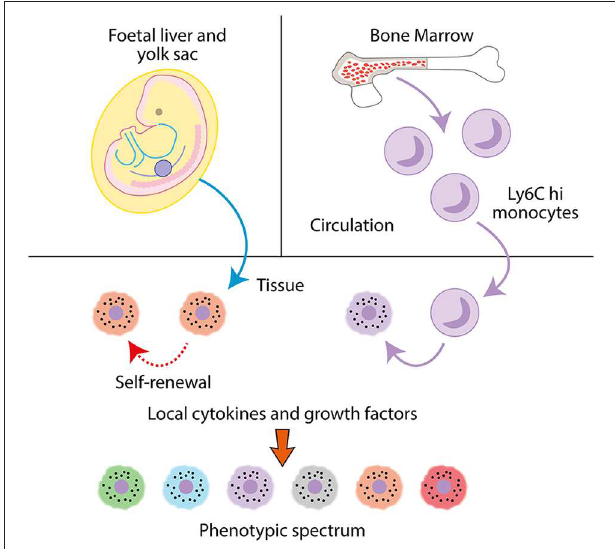
FIGURE 2 | Macrophages are mononuclear phagocytes. Tissue macrophages are seeded during fetal life from the fetal liver and yolk sack and undergo self-renewal. In adults, monocyte precursors extravasate from the bone marrow into the circulation, where they can then infiltrate into tissues and differentiate into macrophages. In tissues, macrophages modulate their phenotype dependent on local cytokines and growth factors to specific tissue or disease-associated